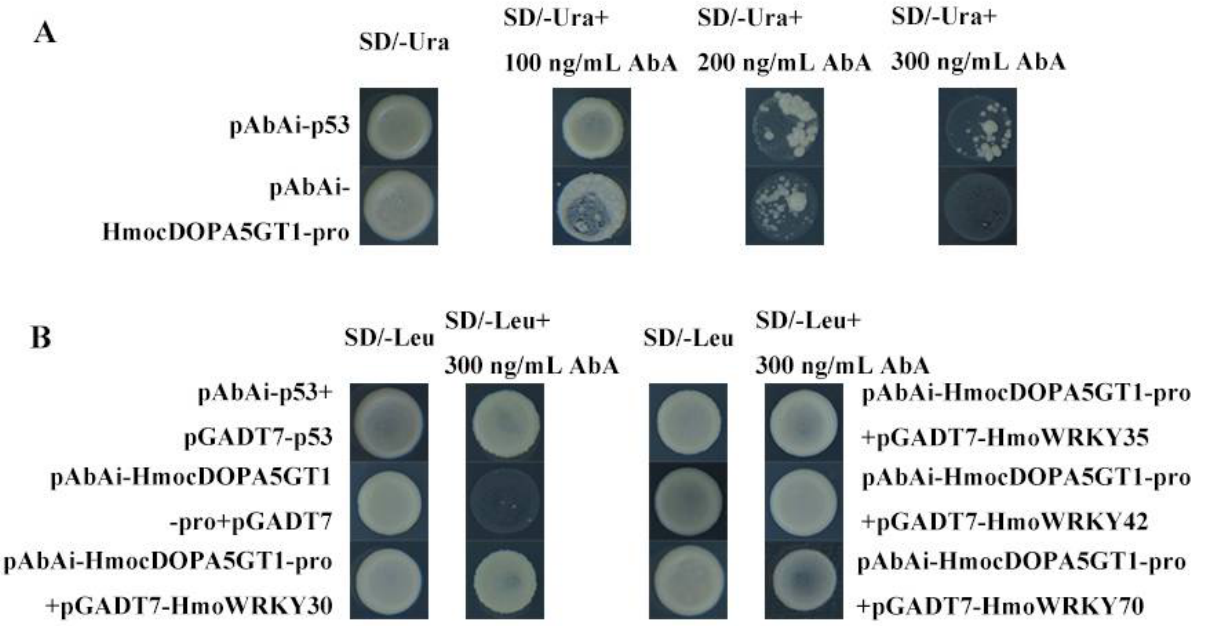
Figure 5. Yeast one-hybrid assays between 53 HmoWRKYs and the HmocDOPA5GT1 promoter. ( A ) Self-activation of the HmocDOPA5GT1 promoter. ( B ) Yeast one-hybrid assays between HmoWRKY30/35/42/70 and the HmocDOPA5GT1 promoter.